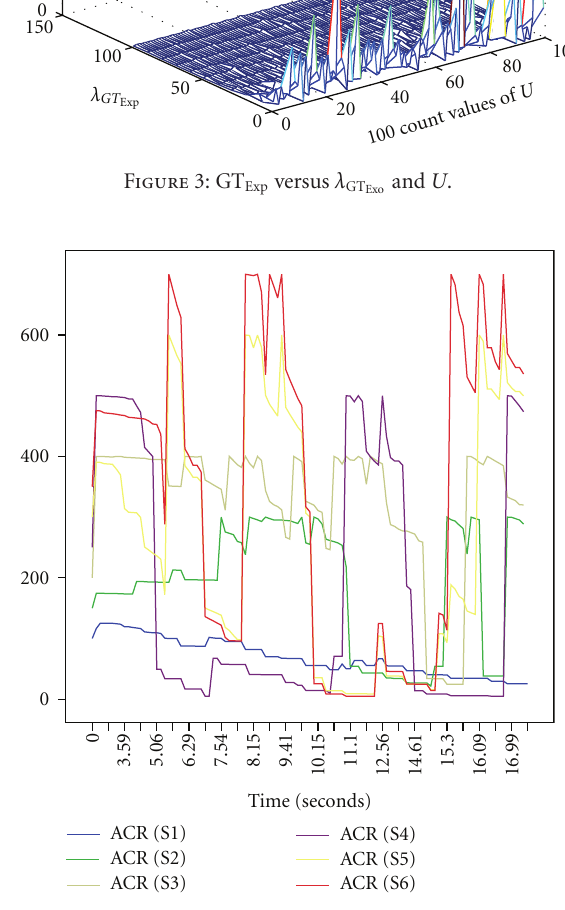
Figure 4: The variation of